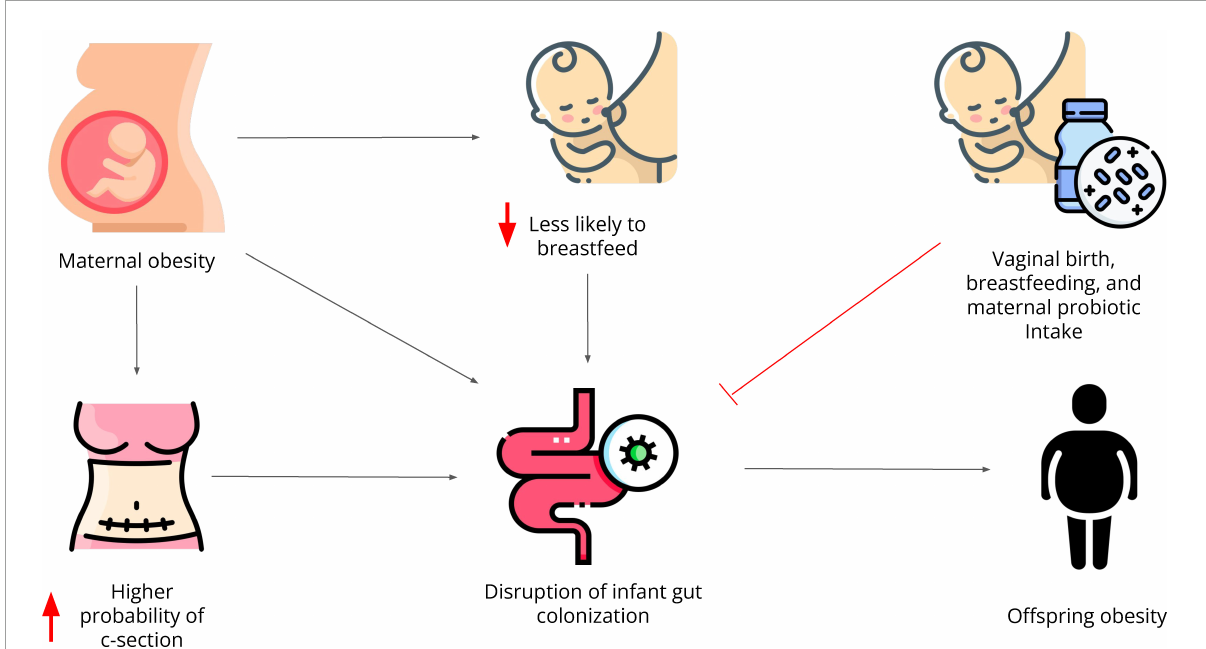
FIGURE1 Maternal obesity directly and indirectly contributes to the intergenerational transmission of obesity through disruptions in the gut microbiota. It increases the likelihood to undergoing C-section and it decreases the likelihood of breastfeeding, both of which have independently shown to negatively affect the offspring’s gut microbiome. Infants with an altered gut microbiota are at higher risk to develop obesity amongst many other comorbidities. Vaginal birth, breastfeeding, and probiotic consumption during pregnancy have shown to protect the infant’s gut microbial diversity and